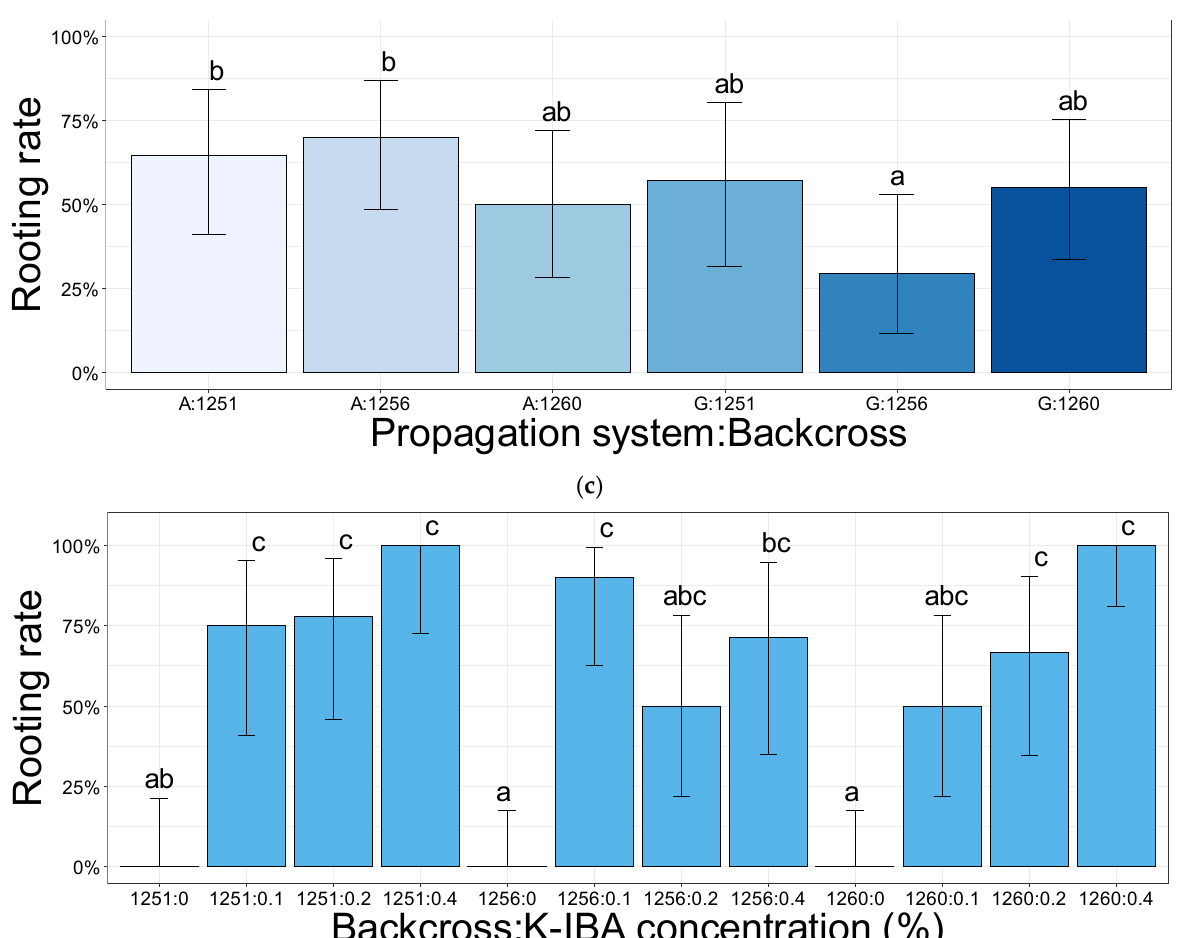
Figure 2. Rooting rate (%) of the softwood cuttings in both propagation systems ( a ) and treated with K-IBA at different concentrations (0.0%, 0.1%, 0.2%, and 0.4% ( w/v )) ( b ). Rooting rate for the interaction propagation system: backcross progenies (1251 = BC1251, 1256 = BC1256, and 1260 = BC1260. A = Aeroponics systems, G = Germination trays). ( c ) Backcross progenies: K-IBA concentration (%) ( d ). Data were calculated after 35 days of rooting. Bars bearing the different letters are significantly different at p < 0.05.